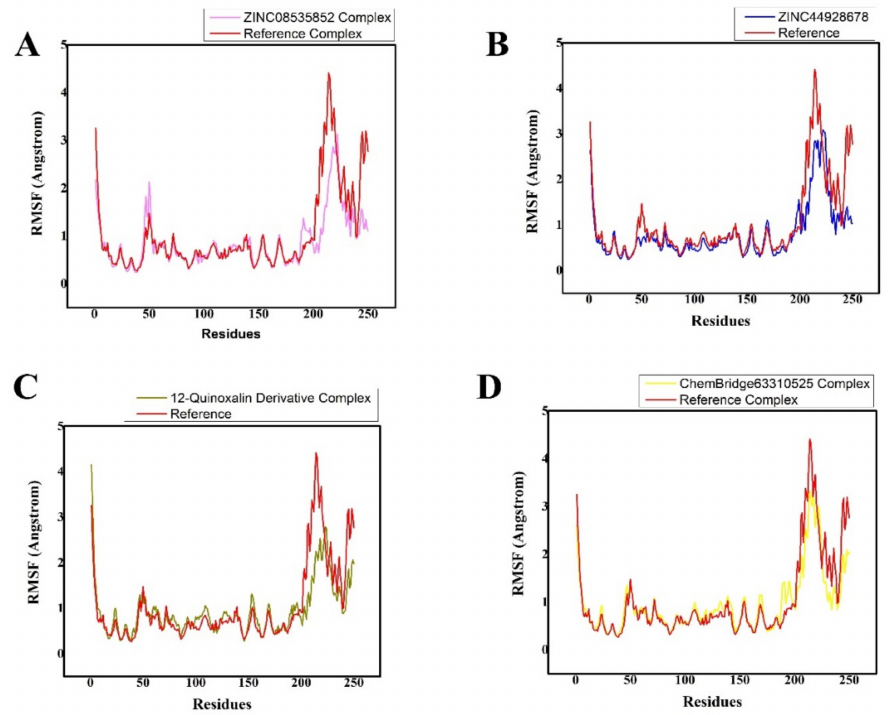
Figure 7. ( A – D ) Plot of the root mean square fluctuation of the identified lead hits/M pro (purple, blue, olive green, and yellow, respectively) and ref-ligand (N3)/M pro (red color) complexes. The various color schemes illustrated various hits/M pro complexes and their related trajectories. Each system possessed the residual flexibility. On the graph, the number of residues is shown along the x-axis, and the RMSF is displayed along the y-axis in angstroms.